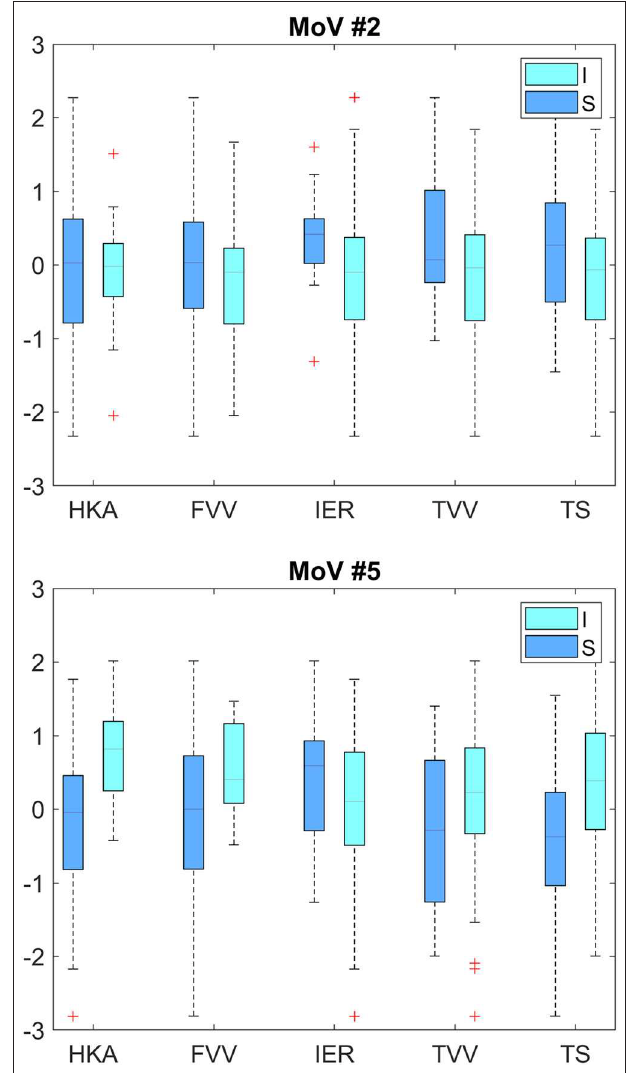
FIGURE 4 | Box plots for MoV #2 and #5 distributions across mechanically stable and unstable cases. Upper plot—HKA ( p = 0.90), VVF ( p = 0.08), IER ( p = 0.02), VVT ( p = 0.08), and TS ( p = 0.06). Lower plot—HKA ( p = 0.0005), VVF ( p = 0.01), IER ( p = 0.13), VVT ( p = 0.09), and TS ( p = 0.002). I, Instability; S,